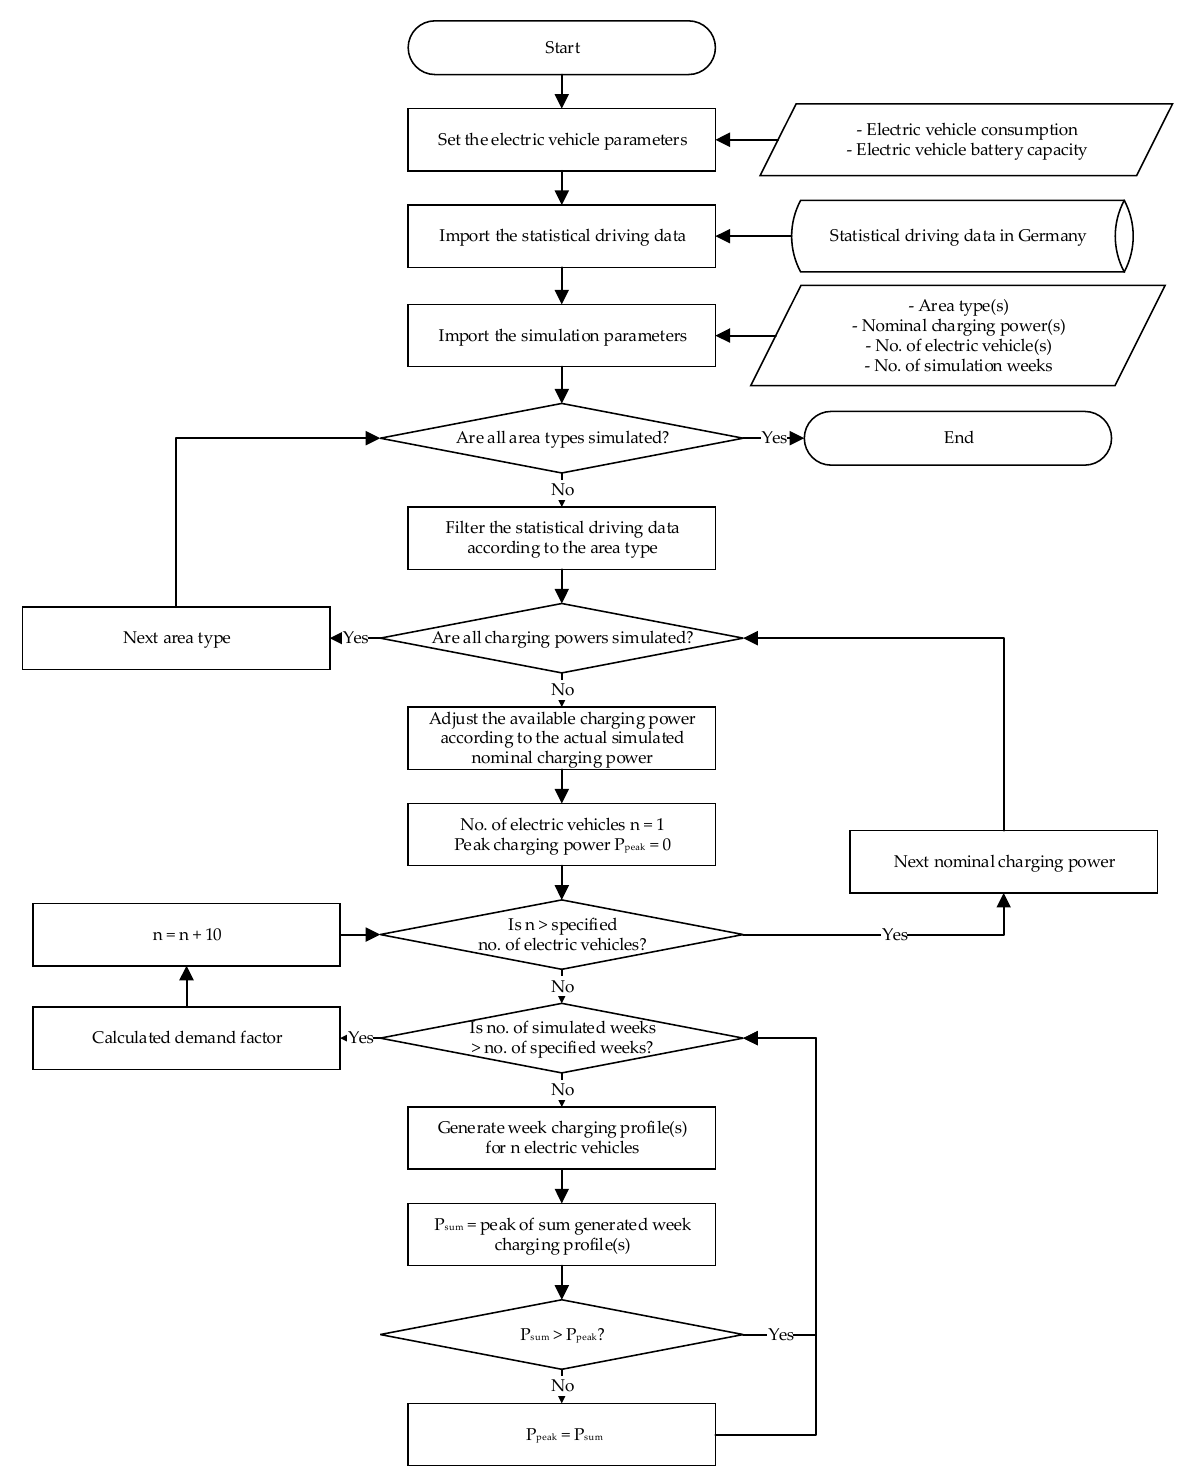
Figure 8. Process diagram for the simulation of charging profiles for different area types and charging